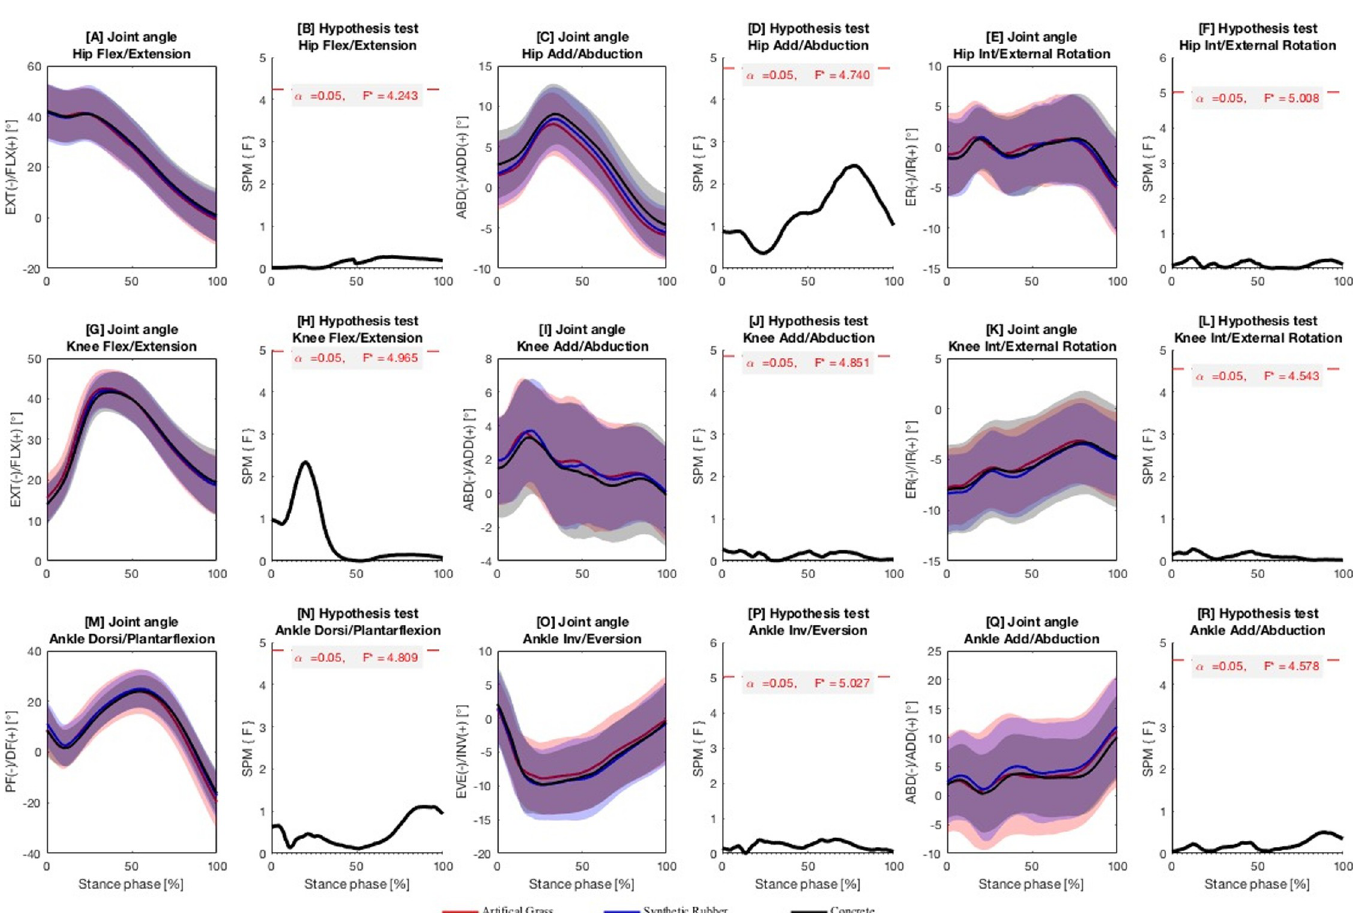
Fig 1. Lower extremity joint angles. Ensemble time series of 3D lower-limb joint angles and the corresponding results of statistical parametric mapping analysis (hip joint angle: A–F; knee joint angle: G–L; ankle joint angle: M–R) across participants during running on artificial grass, synthetic rubber and concrete surfaces. Areas of significant differences are marked in shaded grey. F � = critical threshold.